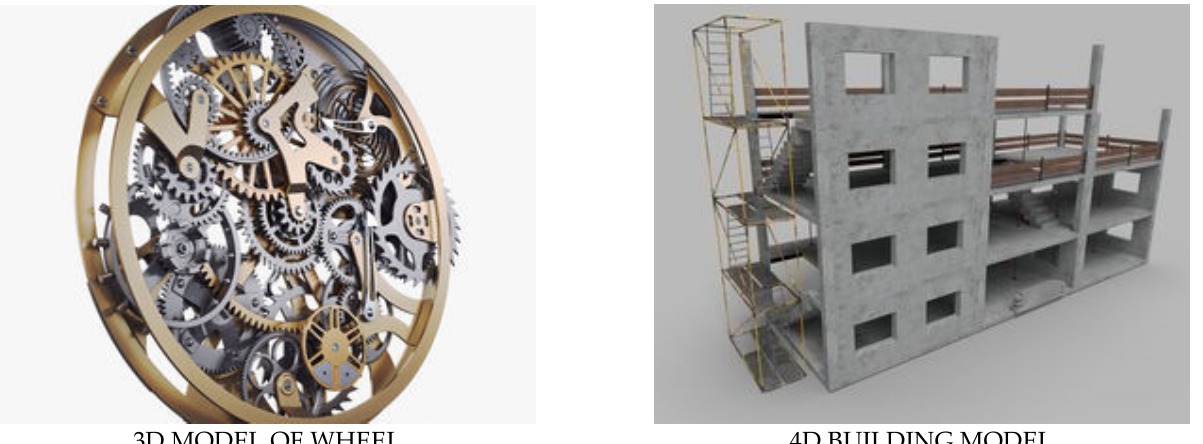
Figure 2. 3D and 4D Models http://3dexport.com/free-3d-models (accessed on 23 May 2022).